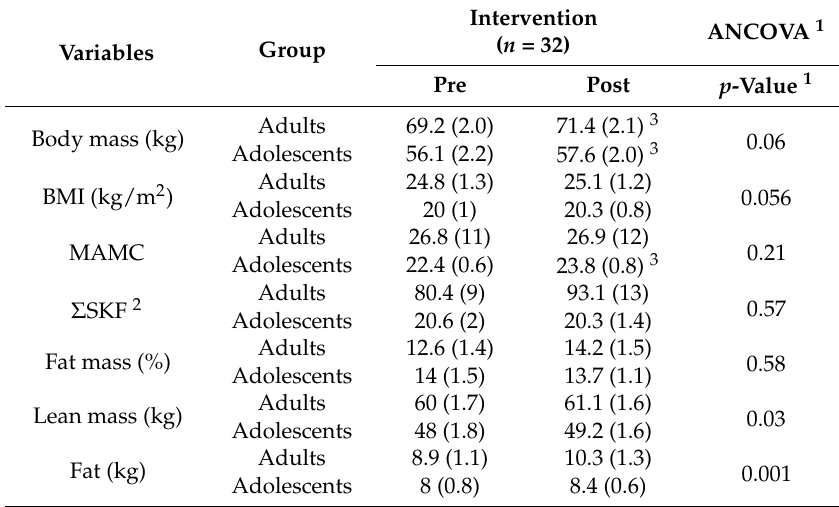
Table 1. Mean (SE) of athlete’s anthropometry and body composition.